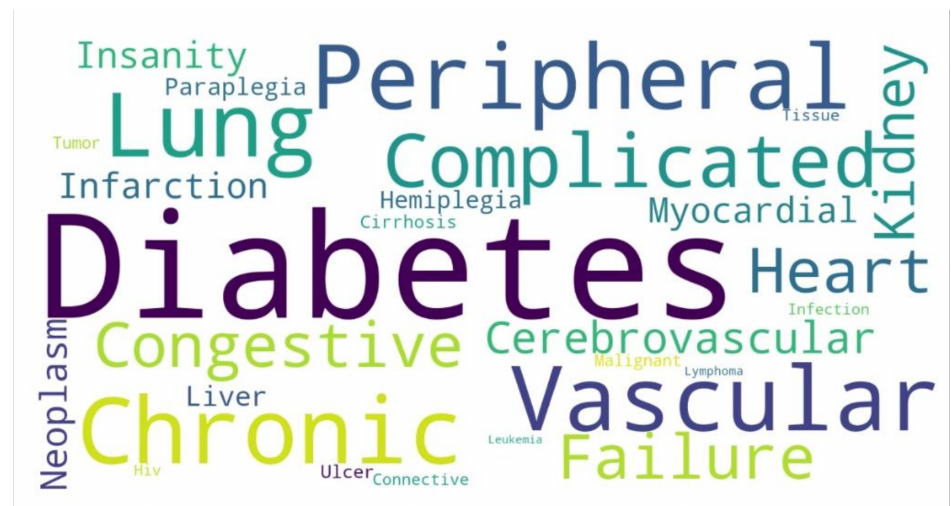
Figure 2. Word cloud of the main comorbidities reported among moderate and severe COVID-19 hospitalizations. Based on RegulaRN data, we identify and analyze the main comorbidities reported on the medical records of each patient. Every comorbidity reported was translated from Portuguese to English and inserted into the word cloud library in Python to generate the word